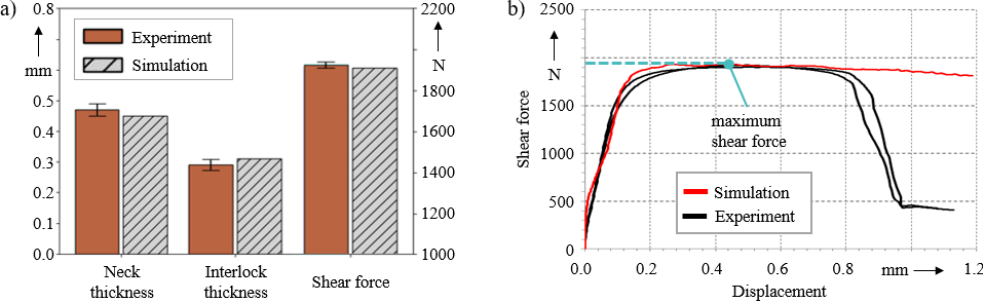
Figure 3. Experimental validation of clinch joint properties ( a ) and force-displacement shear curve ( b